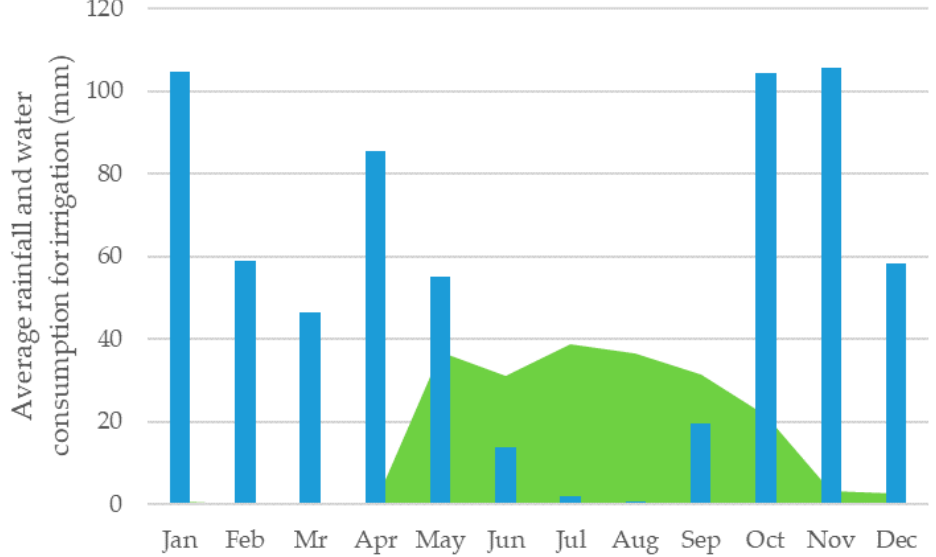
Figure 2. Typical monthly average rainfall (vertical bars, mm) and the average consumption of water for irrigation of the green spaces in the campus, in equivalent units (shaded area, mm). Precipitation data from SNIRH-APA datasets [54].